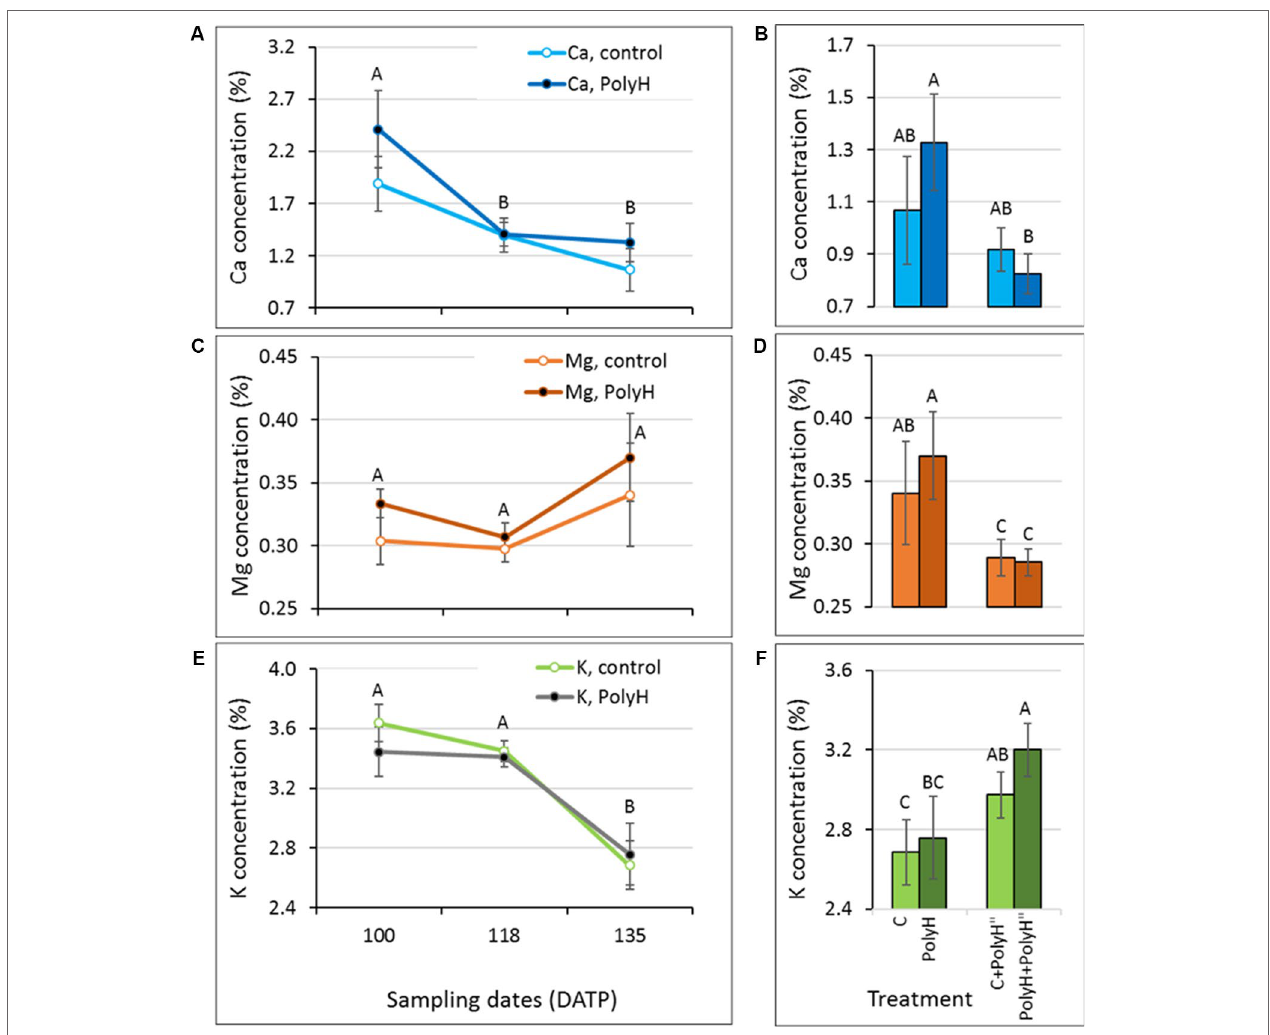
FIgURE 1 | Ca, Mg, and K concentrations in the peel of maturing Rosanna tubers following polyhalite fertilization (experiment 1). (a , C , E) Potato plants were fertilized with polyhalite preplanting (PolyH); control plants (C) were not fertilized. Tuber peel was collected at 100, 118, and at harvest, 135 DATP. Haulm desiccation was applied at 120 DATP; hence, the skin-set process occurred between that time and 135 DATP. (B , D , F) Late application of polyhalite, 2 days after haulm desiccation, to both PolyH plants (PolyH+PolyH") and their controls (C+PolyH"). Peel samples were collected at 135 DATP together with the PolyH and C samples. Bar charts compare mineral elements concentrations in mature peel at 135 DATP following polyhalite application at time of planting and polyhalite application following haulm desiccation. Mineral elements concentrations are given as percentage of peel dry weight. (a , B) refer to Ca, (C , D) to Mg, and (E , F) to K concentration. Values are averages of six replicates with SE. Two-factor analysis—time and treatment—was performed with data of charts (a , C) , and (E) . No interaction was found. Different letters indicate significant difference by Student’s t -test ( P < 0.05) between time points, with no difference between treatments. Data of charts (B , D) , and (F) were analyzed for statistical significance as one variable (treatment) by Student’s t -test; different letters indicate significantly different values ( P <